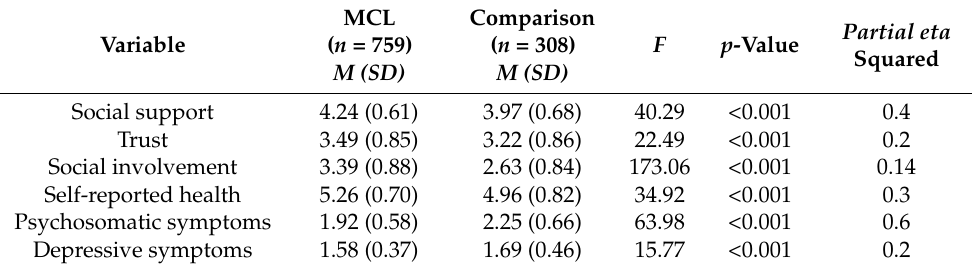
Table 3. Study variables for MCL and comparison groups.